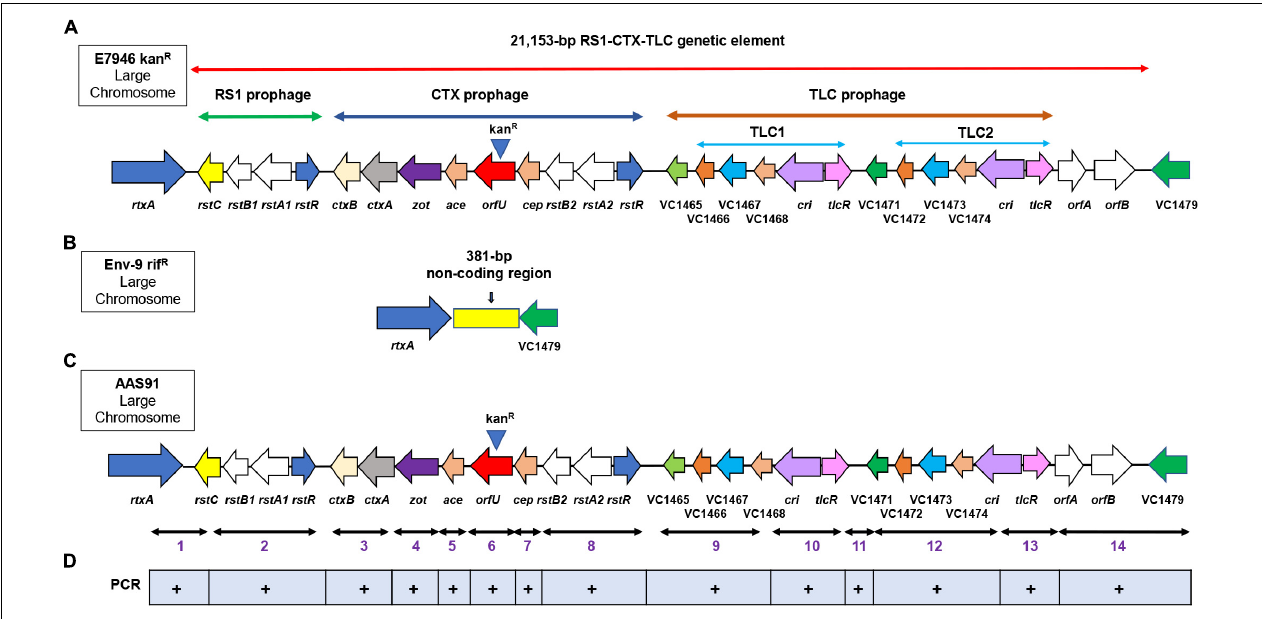
FIGURE 1 | Genetic arrangement of RS1, CTX and TLC (RCT) prophages in the large chromosome of Vibrio cholerae O1 strain. (A) genomic DNA (gDNA) of a wild-type V. cholerae E7946 strain was used as the donor DNA in chitin-induced transformation, encompassing 21,153-bp encoding RCT which was genetically marked with a kanamycin resistance cassette (kan R ) (note, kan R at the top of orfU gene) replacing orfU gene in CTX prophage. The arrows show either gene name, VC followed by a number or ORF designation. (B) Env-9 rif R , served as a recipient strain in chitin-induced transformation, lacking the RCT prophages while retaining a 381-bp non-coding region that is present between rtxA (VC1451) and VC1479 encoding a hypothetical protein. (C) following chitin-induced transformation, Env-9 rif R acquired kan R -marked RCT prophages mirror-imaging RCT of E7946 kan R ; the newly created transformant was designated as AAS91. (D) fourteen convergent PCR primer sets were used to amplify 14 PCR fragments (1–14) confirming all 27 genes present in the RCT prophages both in donor E7946 and transformant AAS91strains. A plus (+) sign indicates presence of the amplicon sequences spanning the targeted region in RCT prophages.